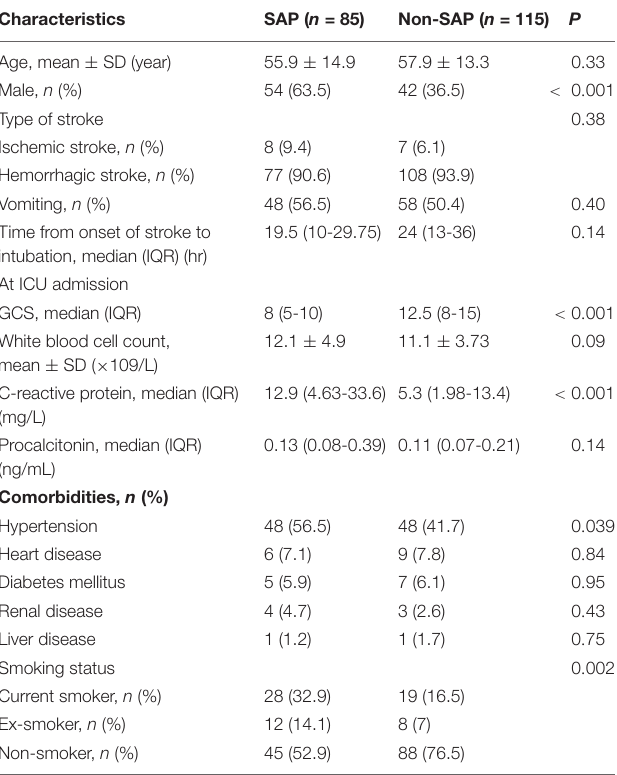
TABLE 1 | Baseline characteristics of the patients with and without microbiologically confirmed SAP at emergency admission.